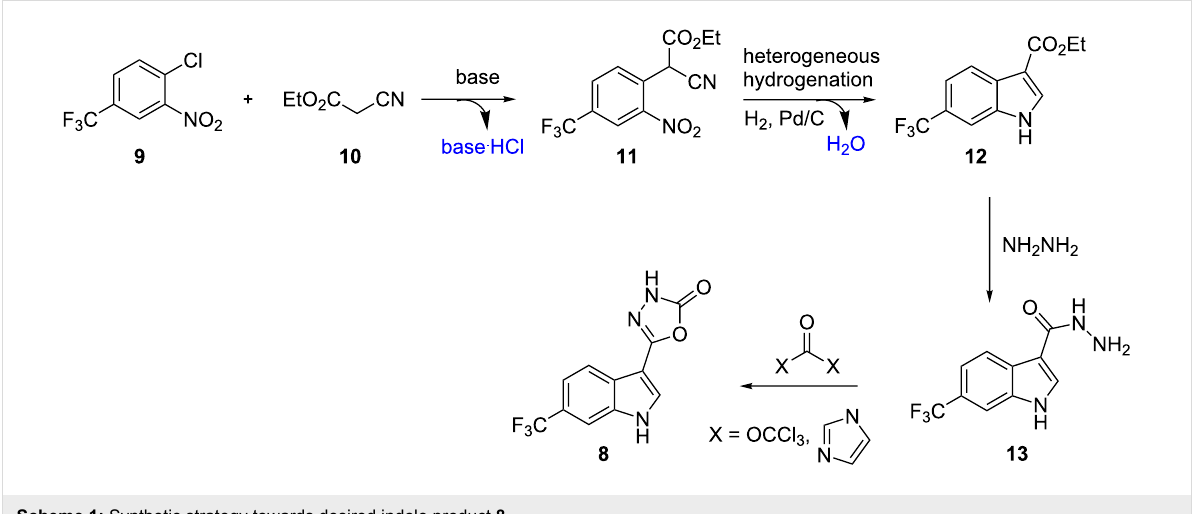
Scheme 1: Synthetic strategy towards desired indole product 8